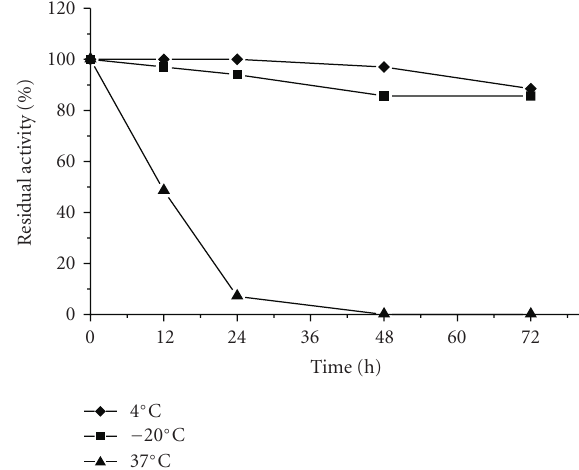
Figure 5: Thermal stability. Purified enzyme was pre-incubated at − 20 ◦ C, 4 ◦ C and 37 ◦ C for the indicated times, and assayed at 37 ◦ C. Residual activity corresponds to the percentage of activity determined for the nonincubated samples